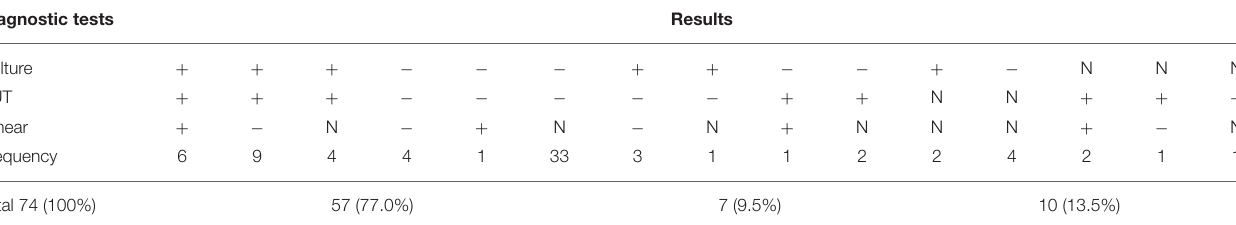
TABLE 2 | The frequency of positive or negative results of culture and RUT of 74 gastric biopsies and microscopic observation of 27 gastric biopsies. Diagnostic tests